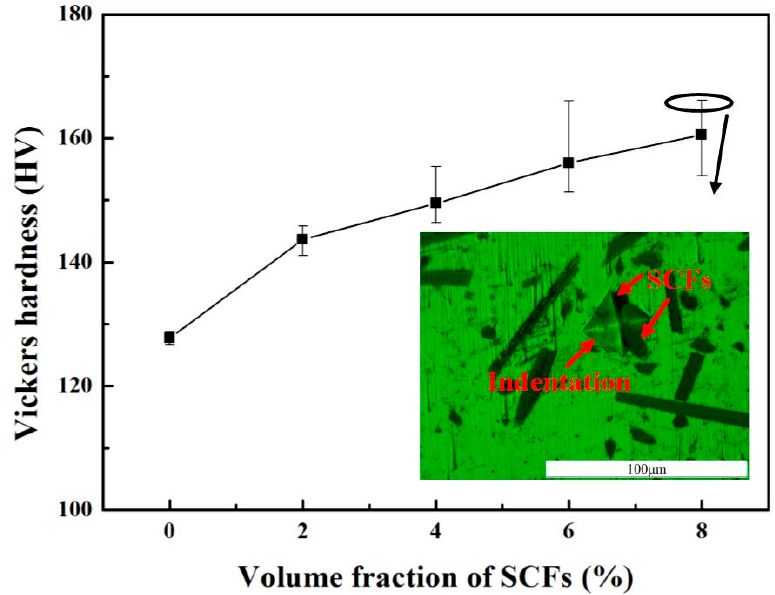
Figure 7. The variation tendency of Vickers hardness with the volume fraction of SCFs, and the inset shows the indentation with high hardness.